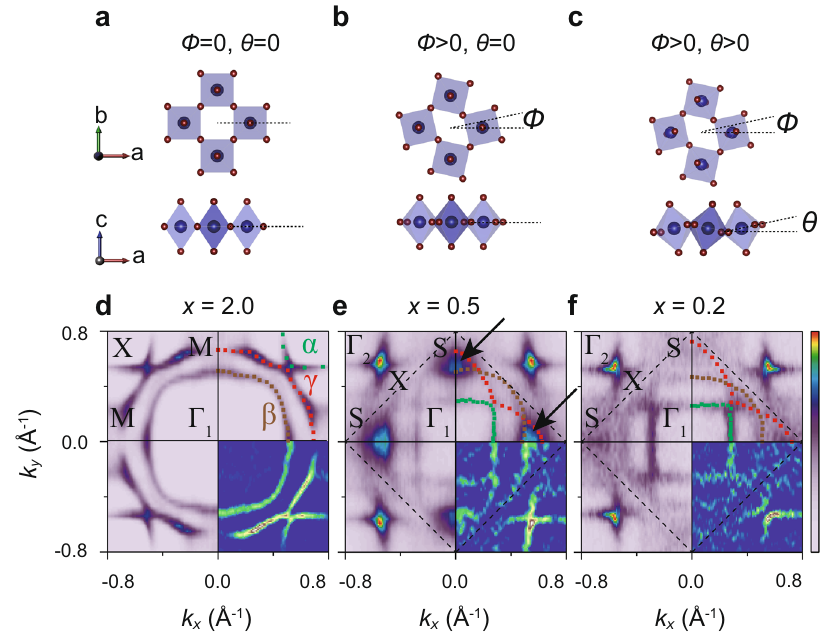
Fig. 1 Crystal structures and Fermi surfaces of Ca 2-x Sr x RuO 4 (CSRO). Top and side view of the CSRO crystal structure a without distortion ( 1 : 5 (cid:1) x (cid:1) 2 : 0 ), b with rotation ( Φ ; 0 : 5 (cid:1) x < 1 : 5 ) and c with both rotation and tilting ( Θ ; 0 : 0 (cid:1) x < 0 : 5 ). Fermi surfaces (FSs, integrated over the Fermi level ( E F ) ± 20 meV) of x = d 2.0, e 0.5, f 0.2 measured at T = 10 K. Colour-coded dots indicate the Lorentzian- fi tted peak positions of α (green), β (brown) and γ (red) FS pockets obtained from the momentum distribution curves (MDCs). The black dashed lines in d – f indicate the reduced Brillouin zone (BZ) induced by octahedral distortions. High-symmetry points in the corresponding symmetry are marked for each substitution ( x ). The right lower part of each panel shows a 2D-curvature plot 50 of the FS map. All the data were measured with π -polarised light ( hv = 70 eV, Supplementary Fig.